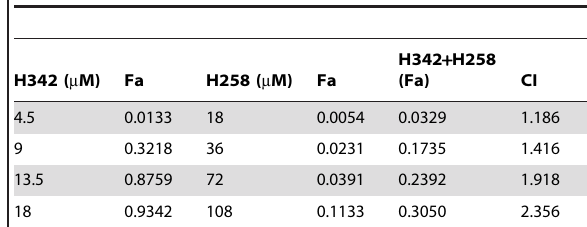
Table 1. Combination indices for H342 and H258 treatment for 24 h, as computed by CalcuSyn for H2373